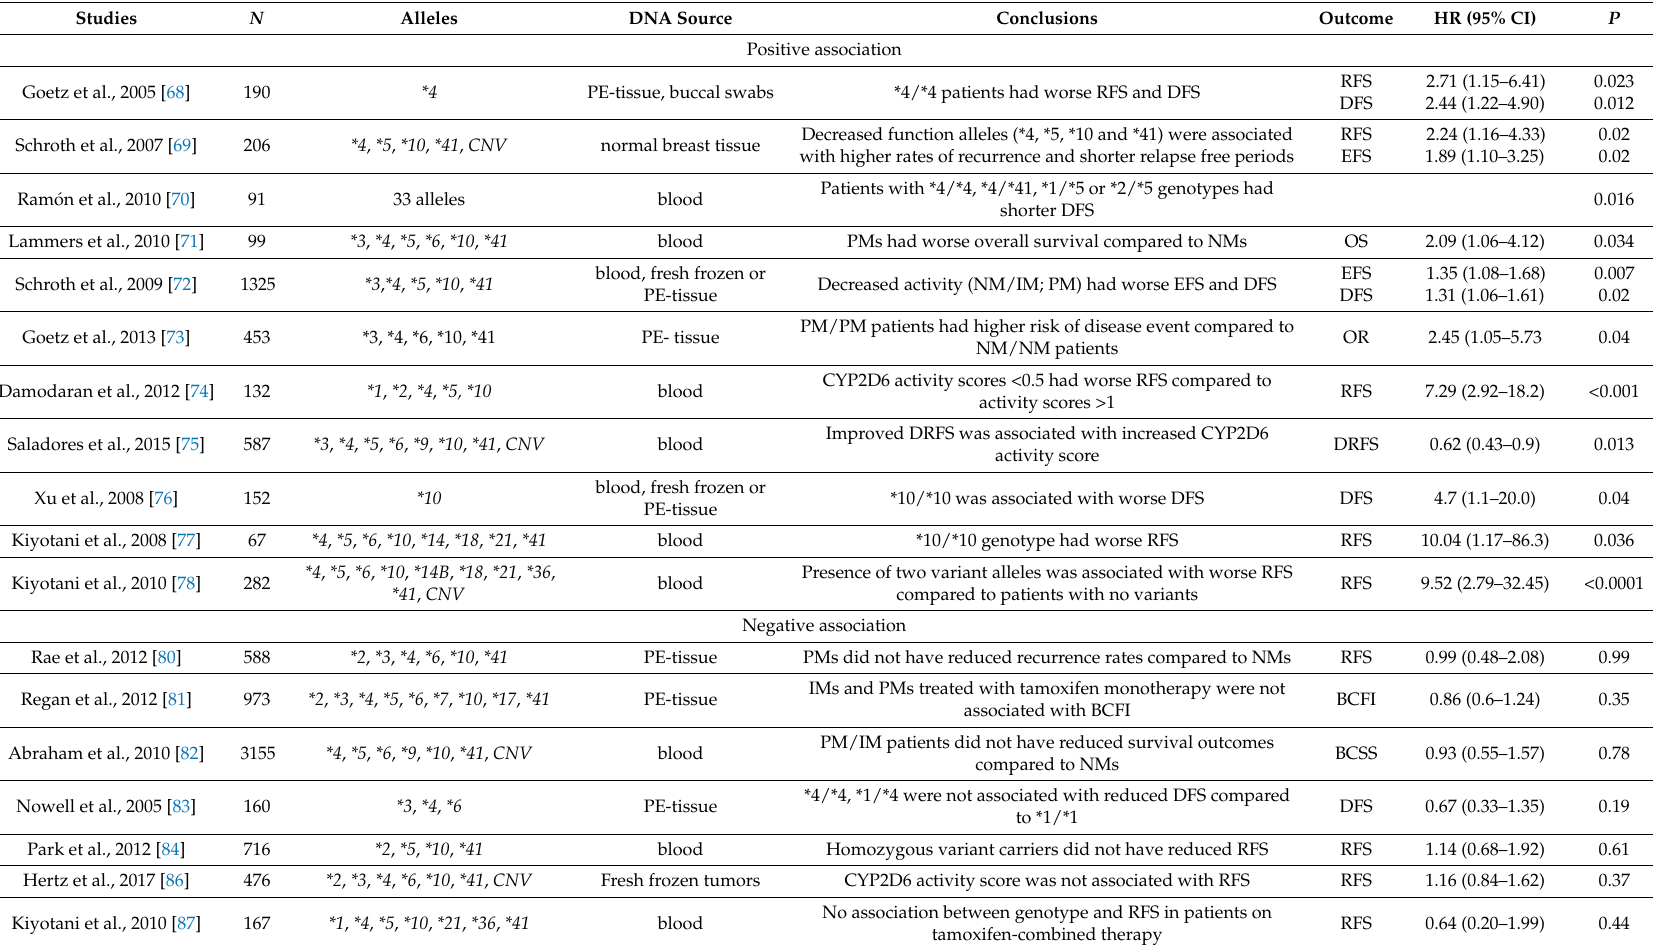
Table 2. Association of CYP2D6 pharmacogenomics with tamoxifen